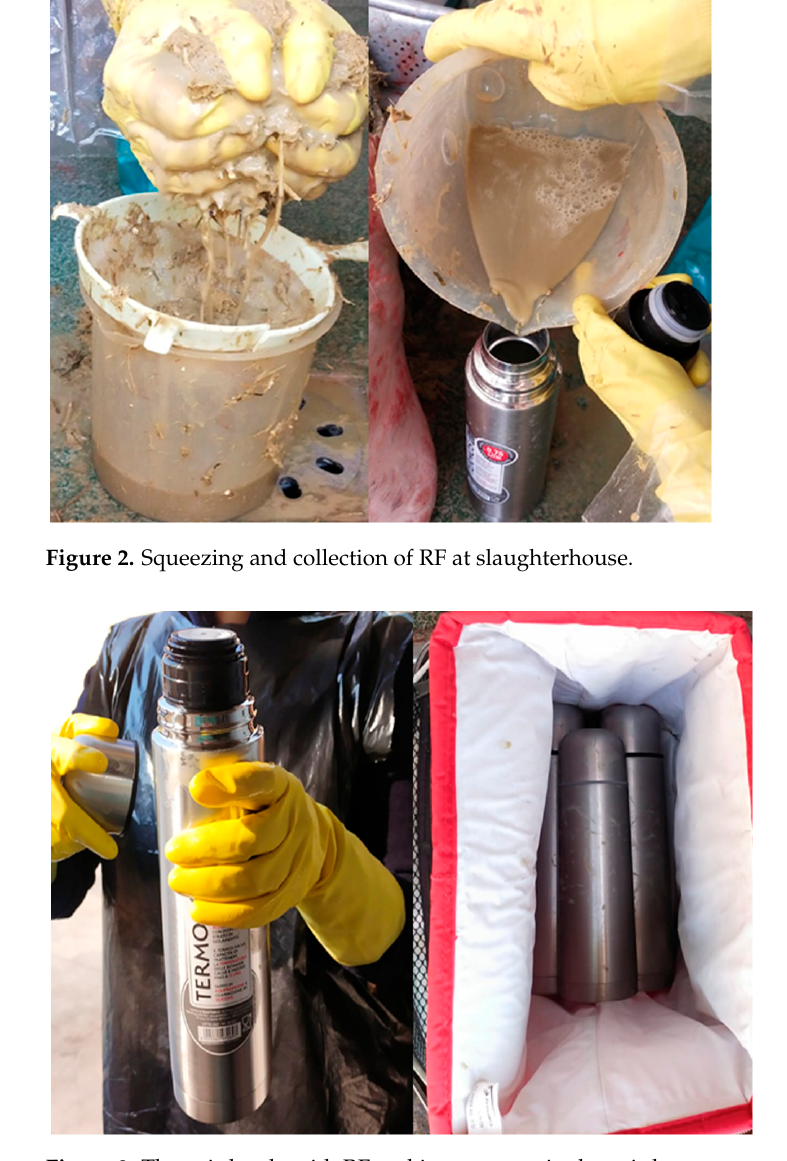
Figure 3. Thermic bottle with RF and its transport in thermic bag.